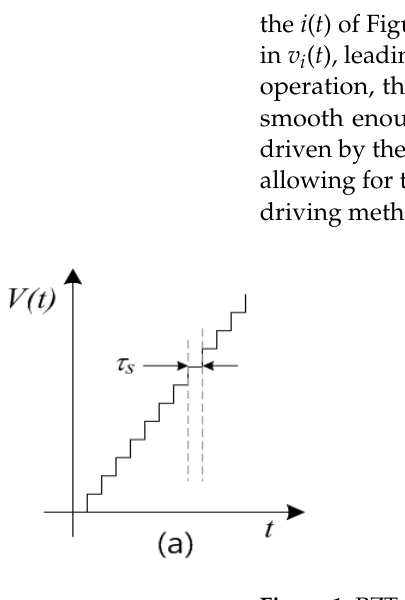
Figure 1. PZT voltage waveforms ( a ) when driven by voltage in open-loop mode, ( b ) when driven by voltage in closed-loop mode, and ( c ) when driven by current in closed-loop mode. V(t) is the PZT voltage. The step height of the current ( i ( t )) is very small because the displacement of current-driven PZT is almost linear. The grey line in ( c ), which is V(t) in ( b ), is added for comparison.